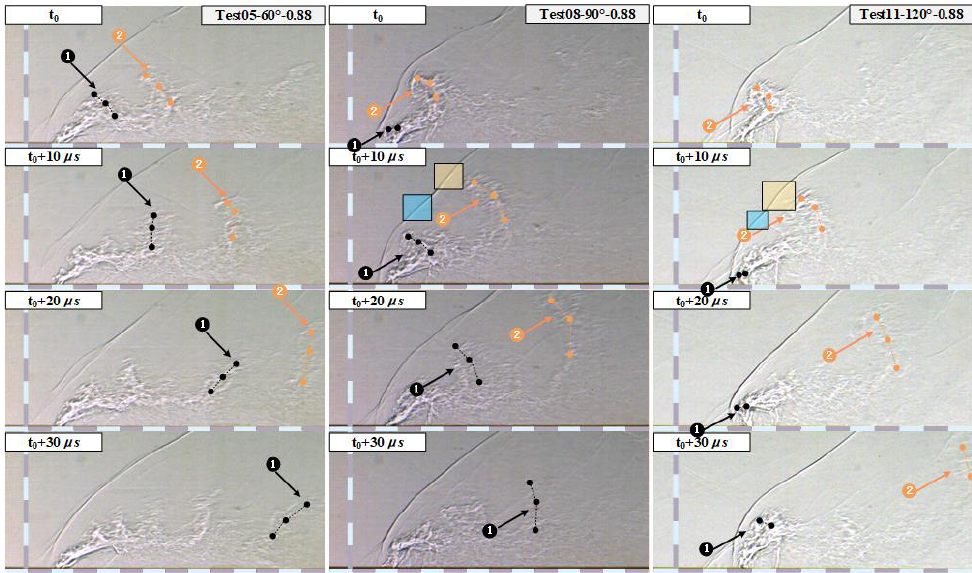
Figure 9. The evolution of the shear vortices under different working conditions.